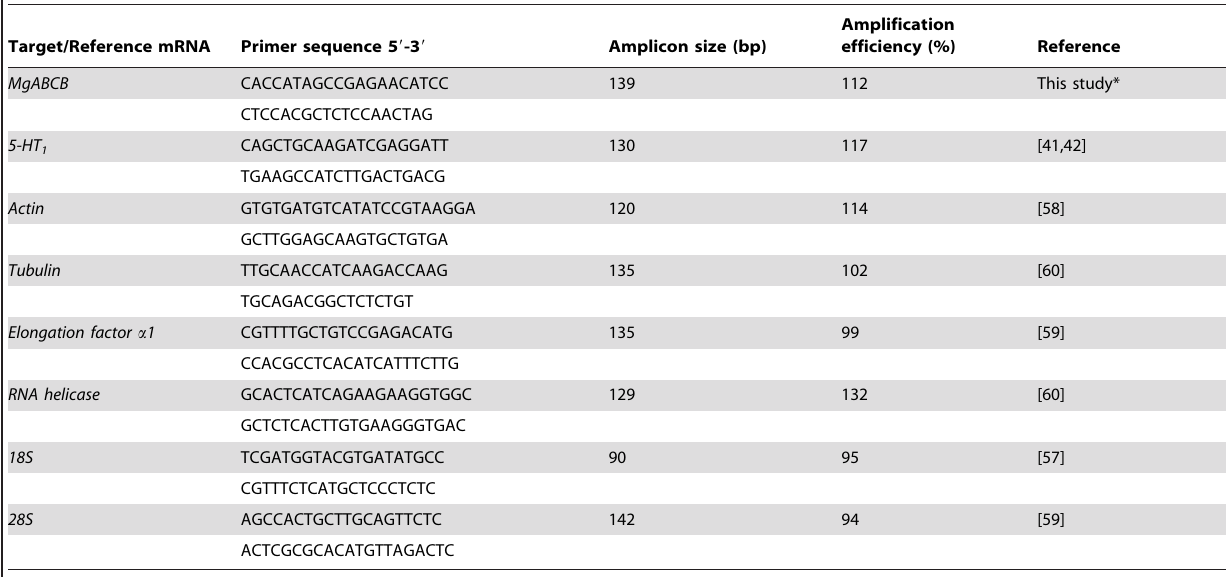
Table 1. List of primers used in real time PCR